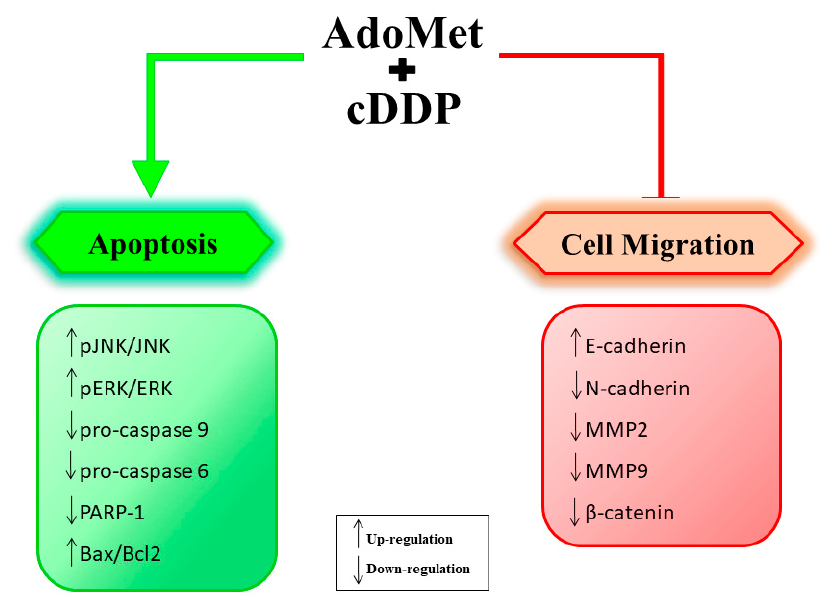
Figure 2. Molecular mechanisms underlying the synergistic effects of S-adenosylmethionine and cisplatin on apoptosis and cell migration in head and neck cancer cells.